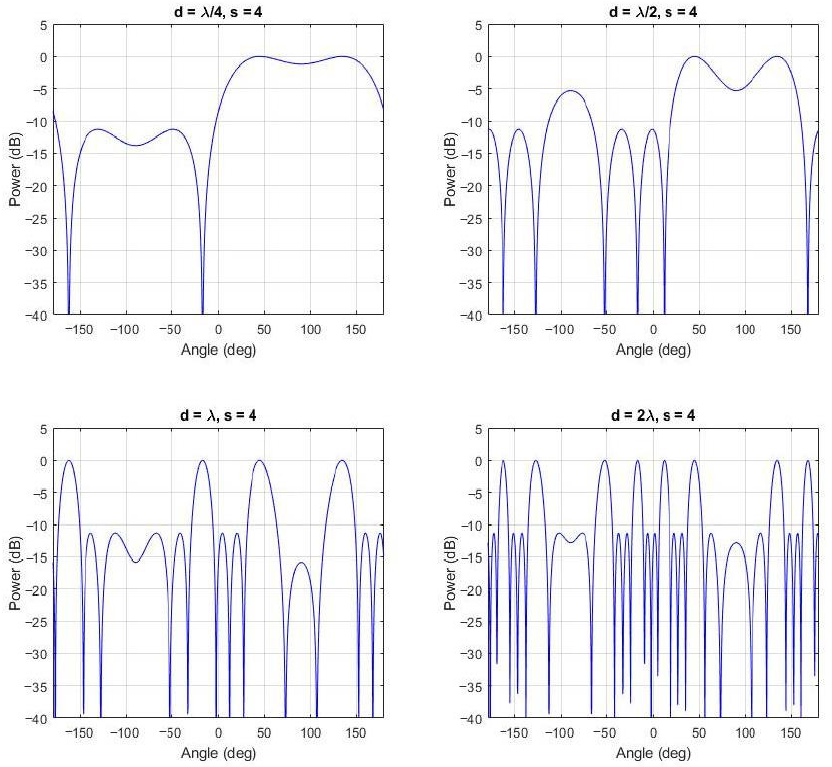
Figure 9. Beampattern analysis for incoming signal at 45° with 4